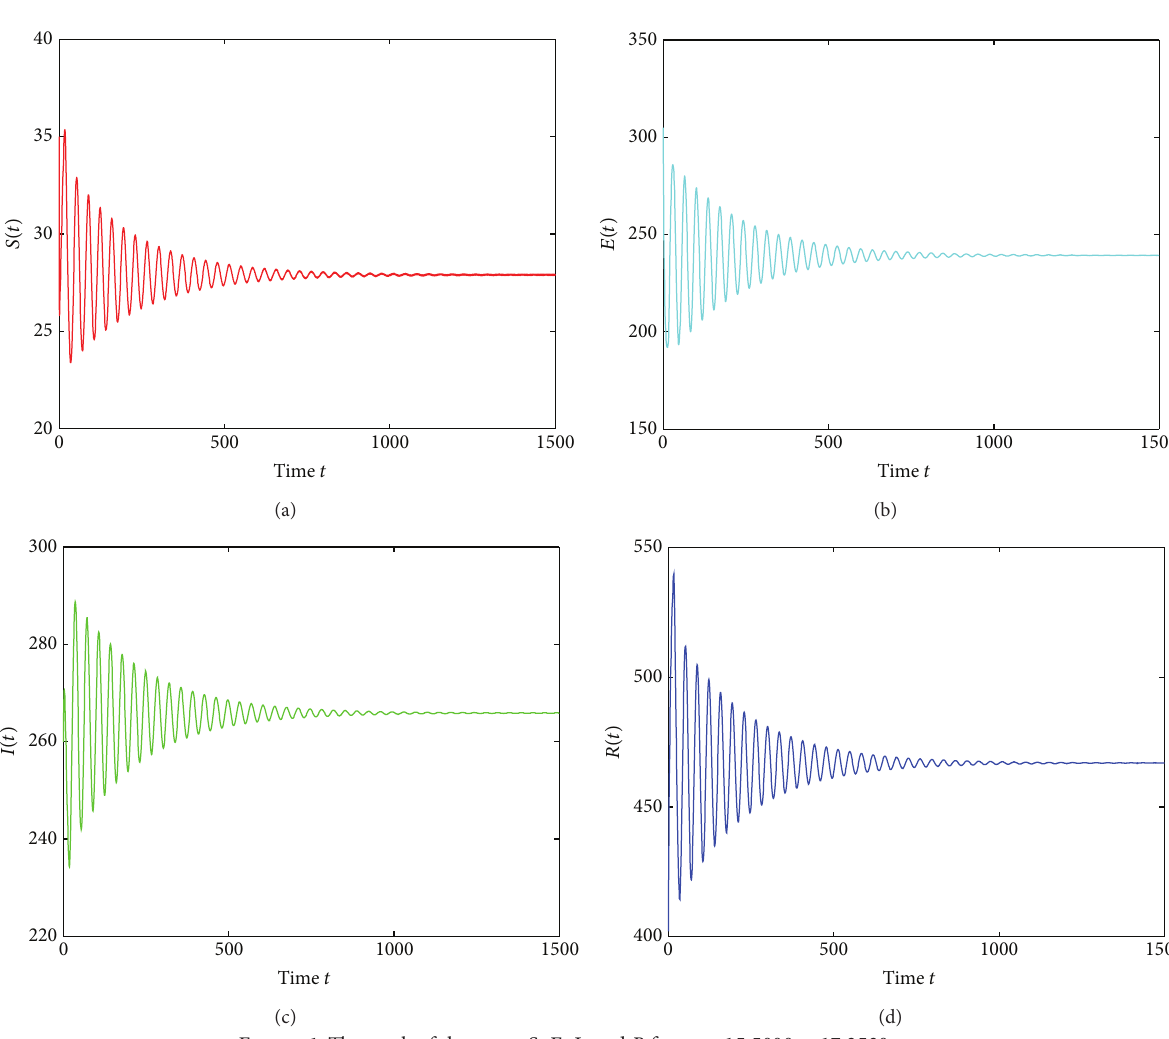
Figure 1: The track of the states 𝑆 , 𝐸 , 𝐼 , and 𝑅 for 𝜏 1 = 15.5000 < 17.2530 = 𝜏 10